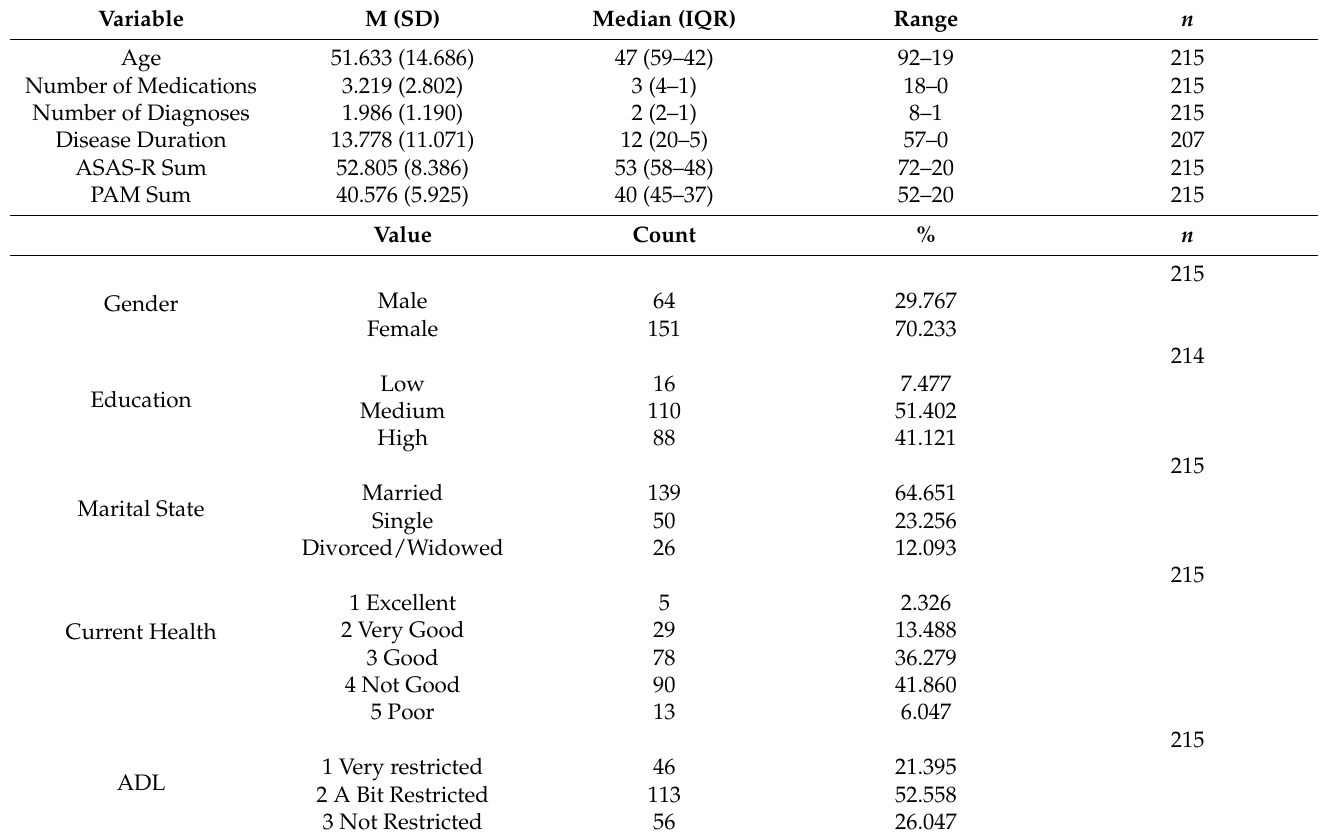
Table 1. Sociodemographic information.